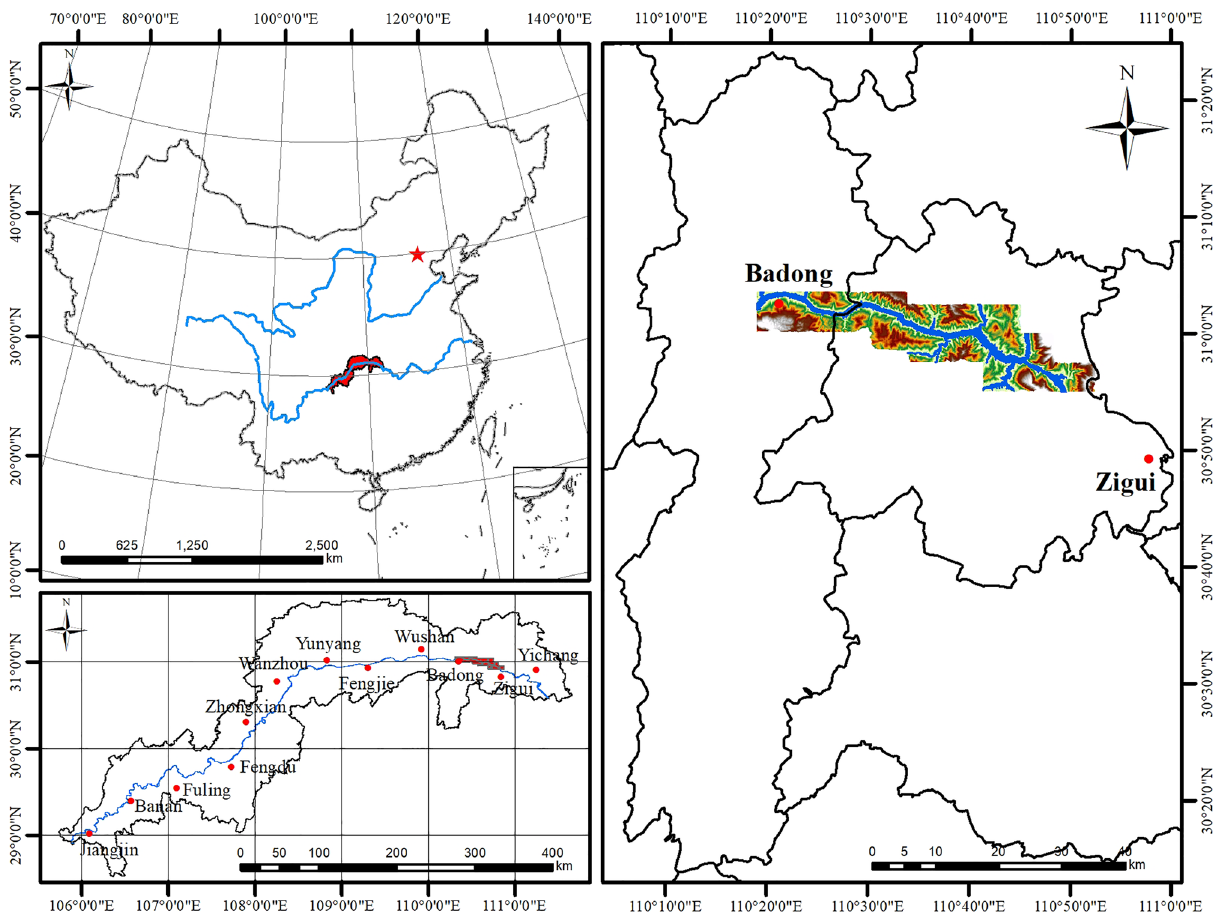
Figure 2. Geographical location of the study area (drawn with ArcGIS 10.8 software, and the URL is: https:// www. esri. com/ en- us/ arcgis/ about- arcgis/ overv iew).